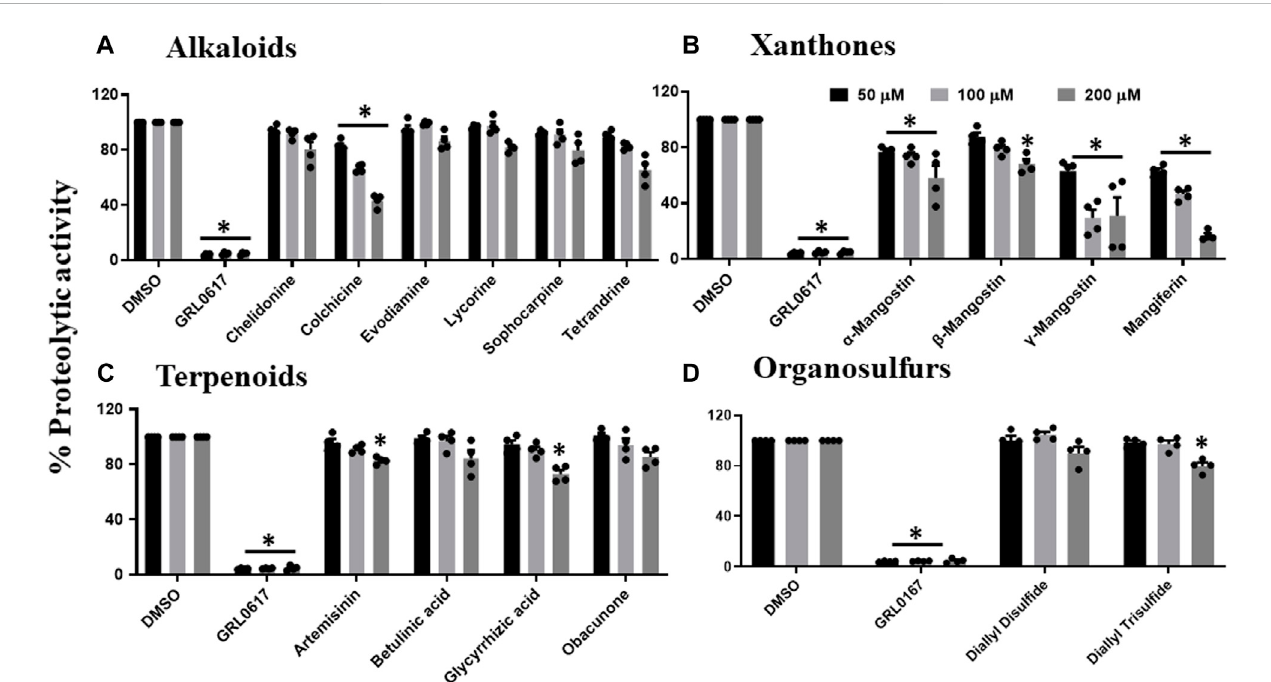
FIGURE 1 Inhibition of proteolytic activity of SARS-CoV-2 PLpro enzyme by selected alkaloids (A) , xanthones (B) , terpenoids (C) and organosulfur molecules (D) . Selected alkaloids, xanthones, terpenoids, and organosulfur compounds were screened for their inhibitory activity against the SARS-CoV-2 PLpro enzyme as describedunderMaterialsandMethods.The fl uorescenceintensitywasusedtocalculatethepercentproteolyticactivityconsideringDMSOtreatedcontrolas 100% activity. Blank values were subtracted before calculating the percent activity. Representatives of four individual experiments (n = 4) with triplicate values were presented graphically and analyzed using GraphPad Prism 8. p < .05 considered as statistically signi fi cant compared to the DMSO control.